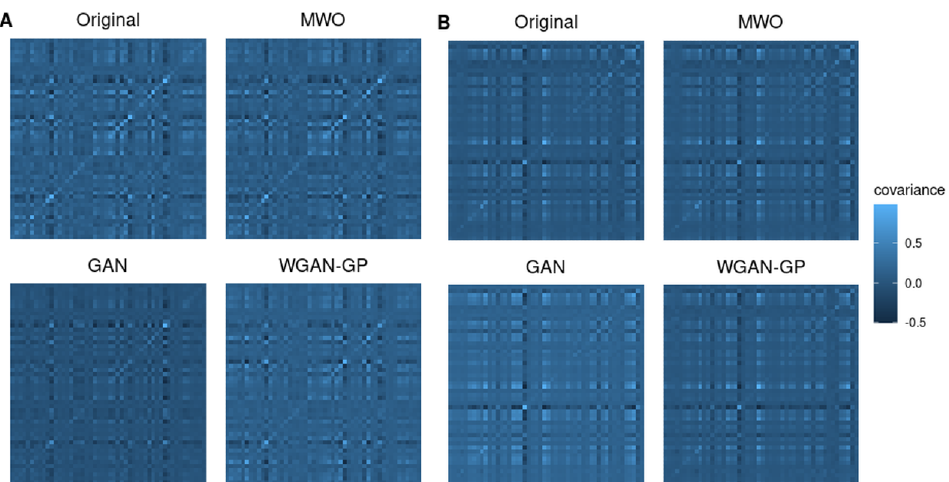
Figure 3. Heatmaps representing covariance matrices for selected genes from the microarray study. Covariance structures of original and artificial samples are compared for two sets of 50 randomly chosen genes. The covariance structures are best maintained when generating artificial samples with the MWO or WGAN-GP approach. The details are showed in ( A , B